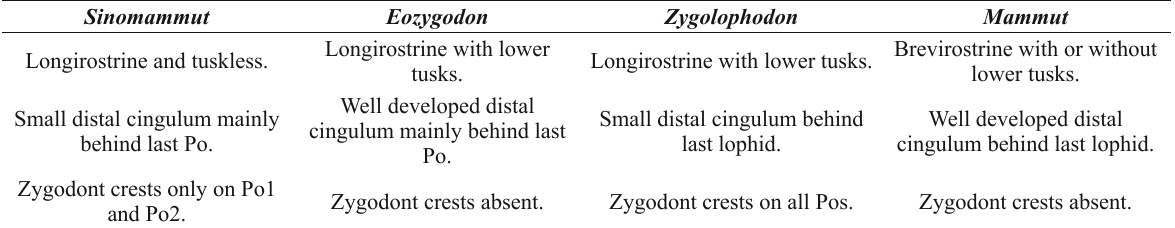
Sinomammut autapomorphies compared to Mammutidae taxa. Note that the set of features of Sinomammut is unique among the Mammutidae.